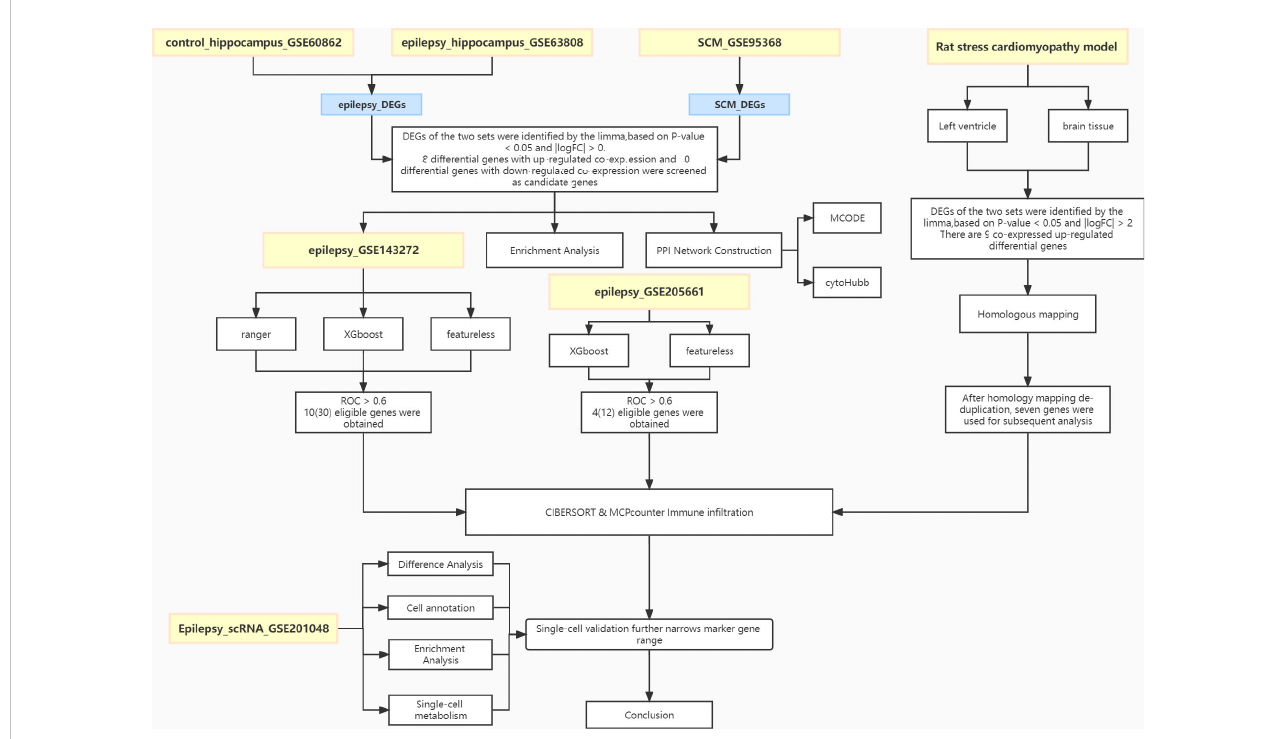
FIGURE 1 Work fl ow of the